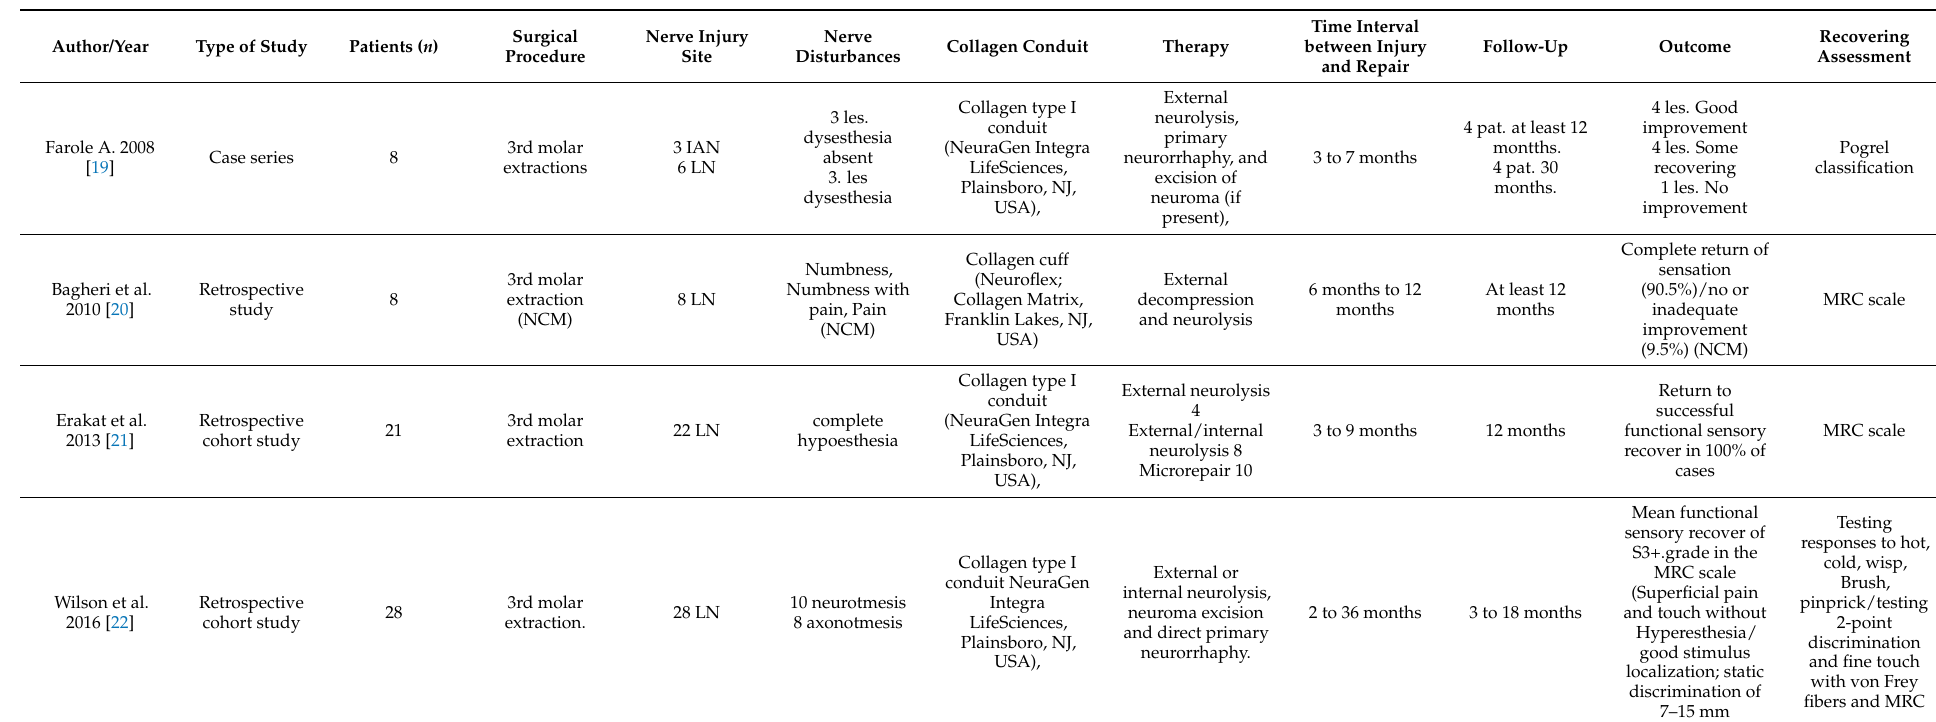
Table 3. Characteristics of the included studies, patients, interventions and